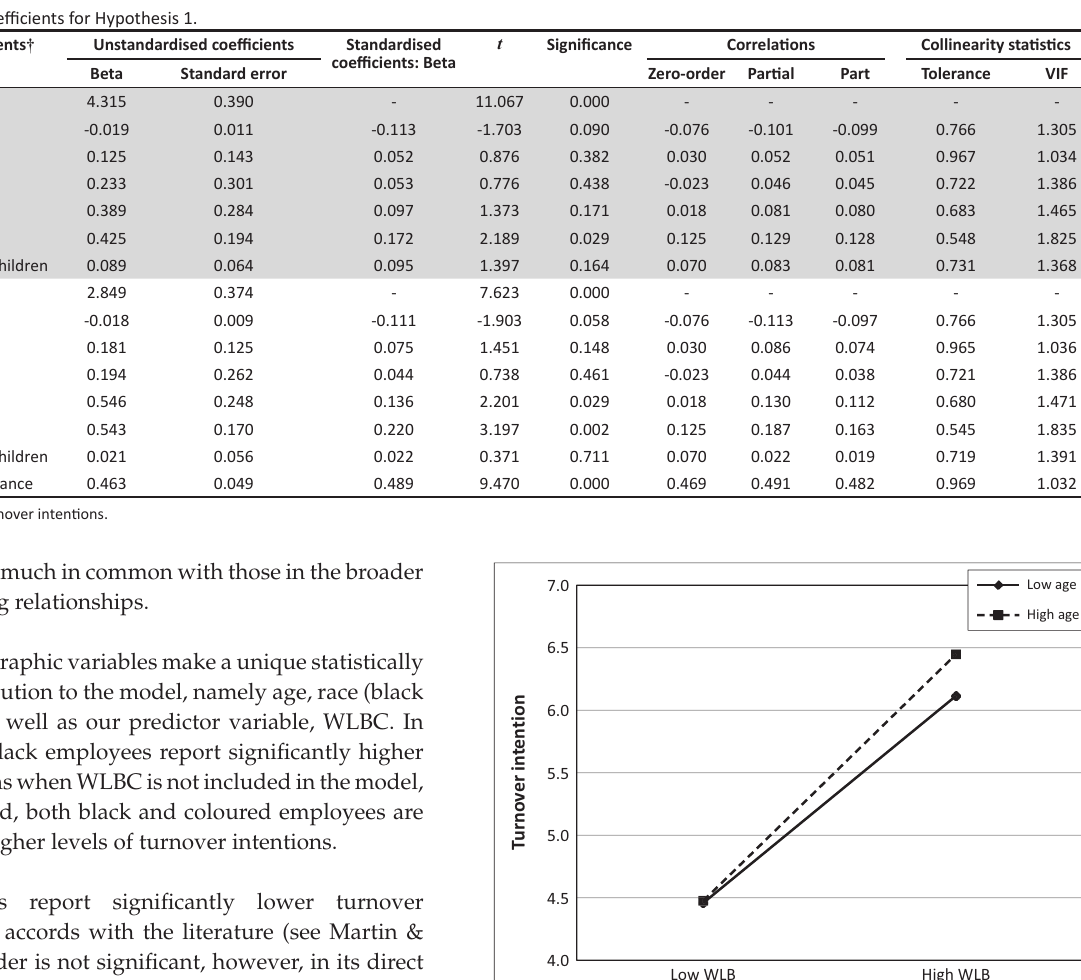
Work-life balance conflict FIGURE 1: Age as a moderator on work-life balance conflict–turnover intention relationship (two-way interaction).